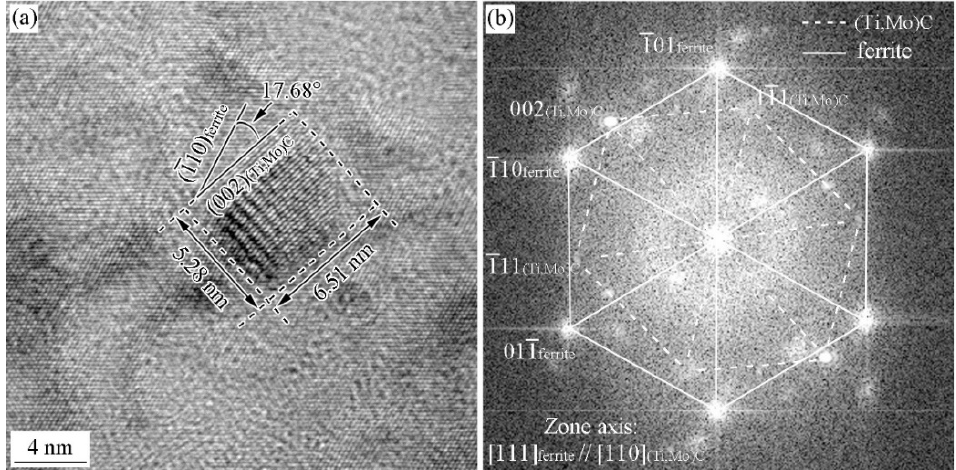
Figure 14. HRTEM image of precipitate and the OR between precipitate and ferrite matrix in Ti-Mo steel produced by process II with the cooling rate of 80 °C/s ( a ) HRTEM image; ( b ) FFT diffracto- gram.